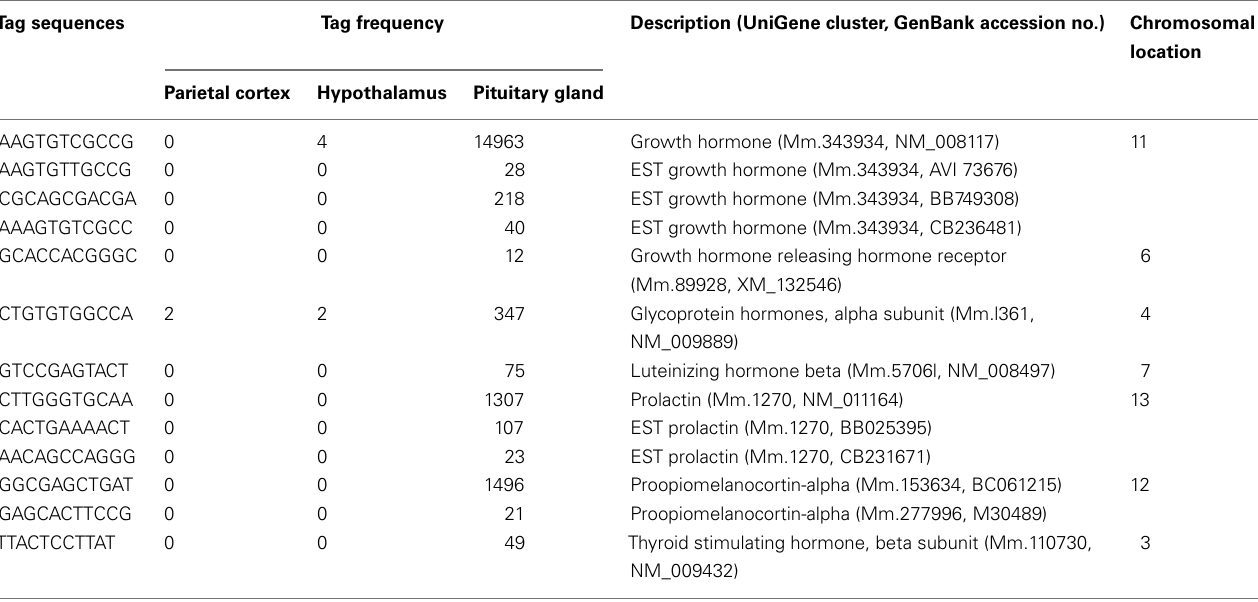
Table 3 | Hormones preferentially expressed in pituitary